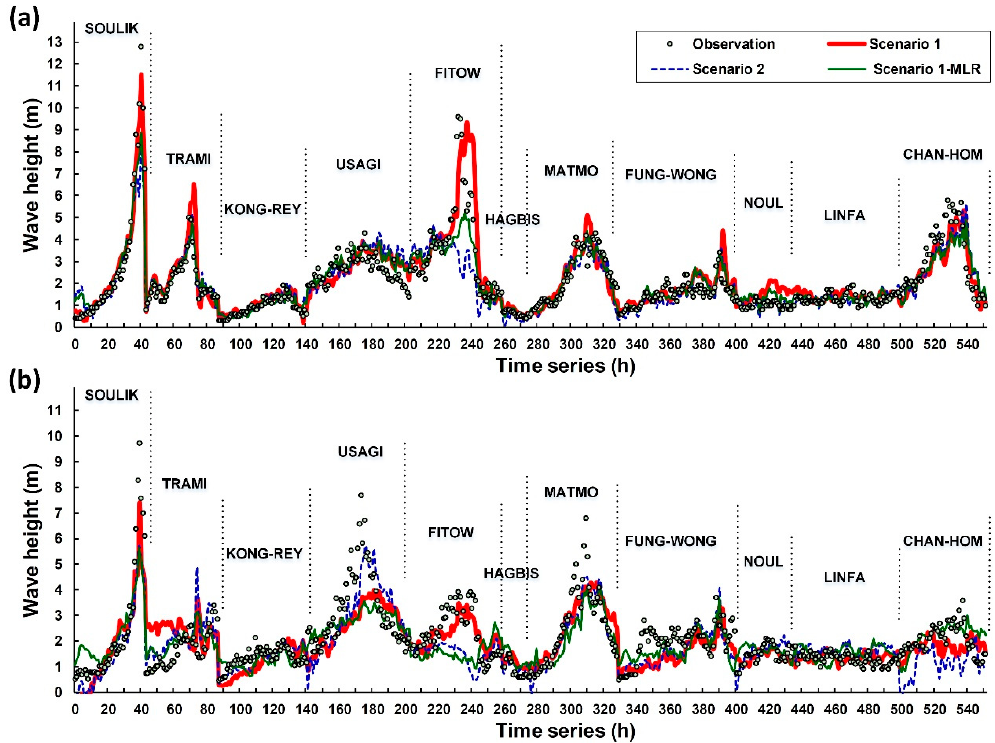
Figure 6. Prediction outcomes for wave height at a lead time of 1 h: ( a ) Longdong buoy, and ( b ) Guishandao